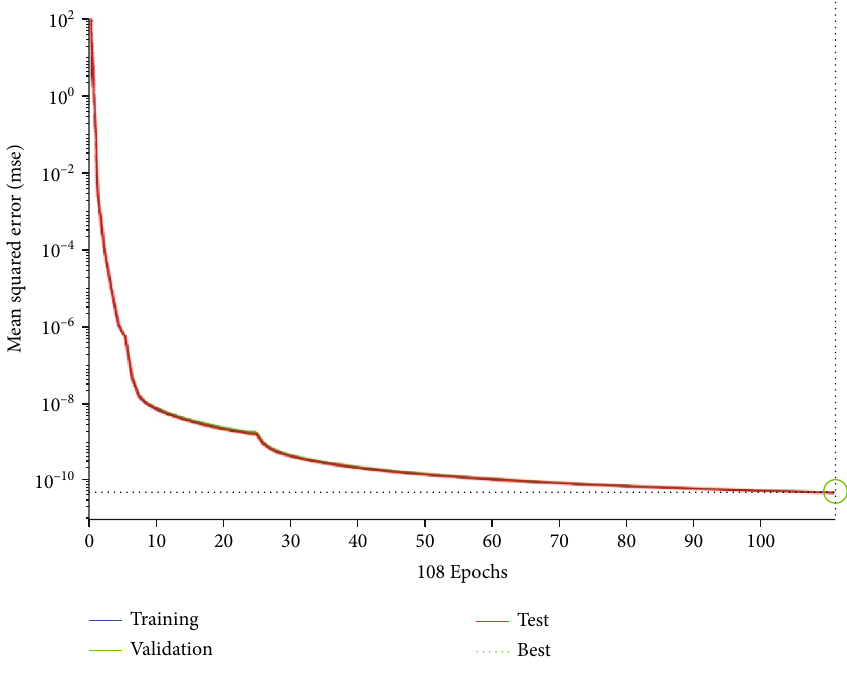
Figure 14: The best validation performance of a DNN-wind MPPT